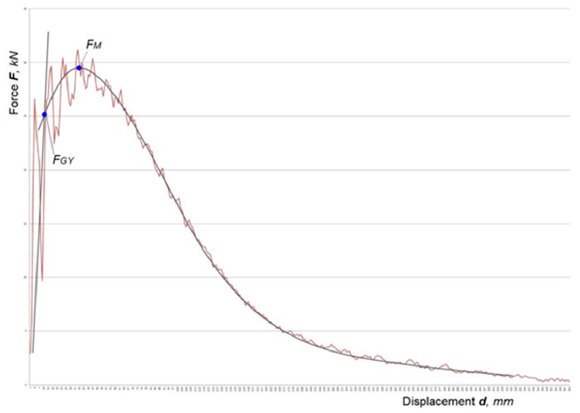
Figure 1. Force-displacement diagram with the elastic slope and curve fitted to the remaining part of the diagram.